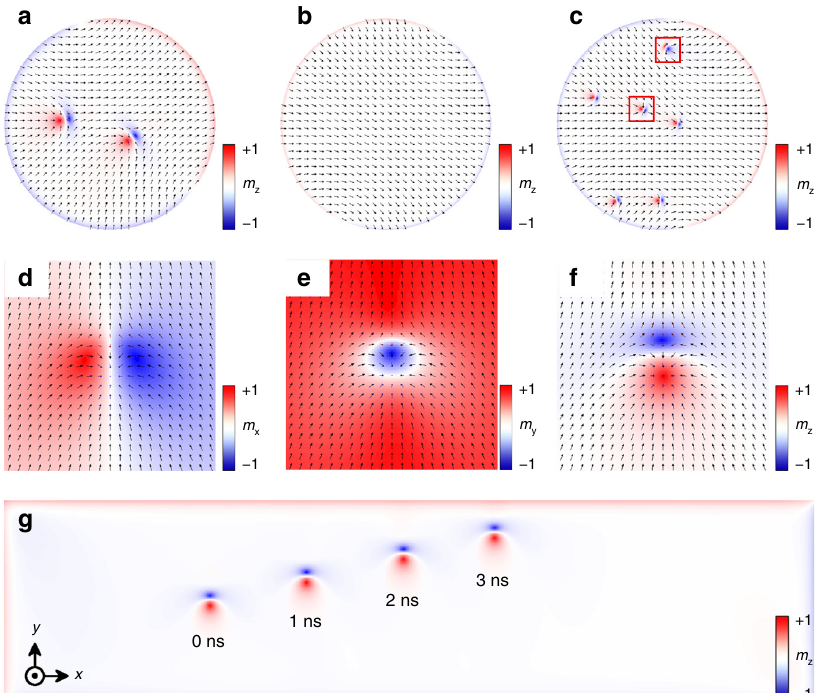
Fig. 2 Ferroelectric regulation and current drive of bimeron. The top views of the micromagnetic simulation for ( a ) LaCl/ P + and ( b ) LaCl/ P − HSs. c The top views of the micromagnetic simulation for LaCl/ P − HS with K = − 0.1 meV, the red rectangle shows two bimerons with opposite topological numbers. d – f Blue – red color represents the region of x , y , z component along the magnetic direction of a bimeron. g Snapshots of the bimeron moving under a current of j = 3 × 10 10 A m − 2 on nanotracks.